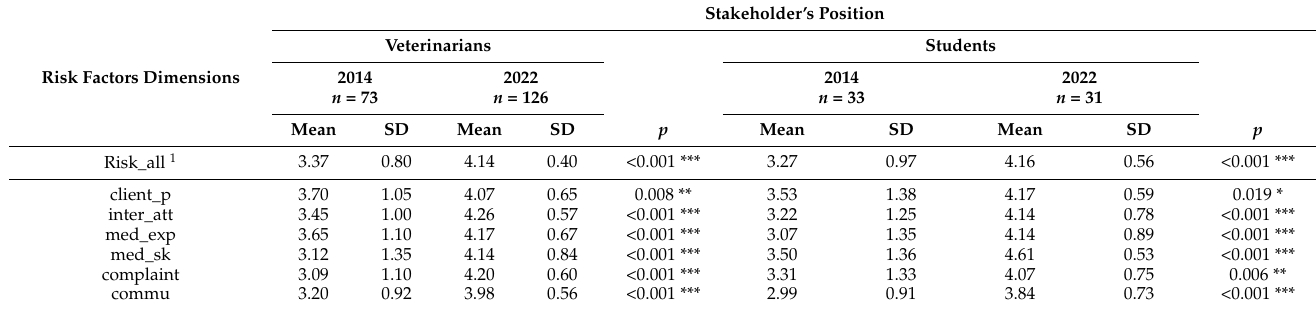
Table 9. Comparisons of the risk factor perceptions differences between 2014 and 2022 for veterinari- ans and students subgroup.